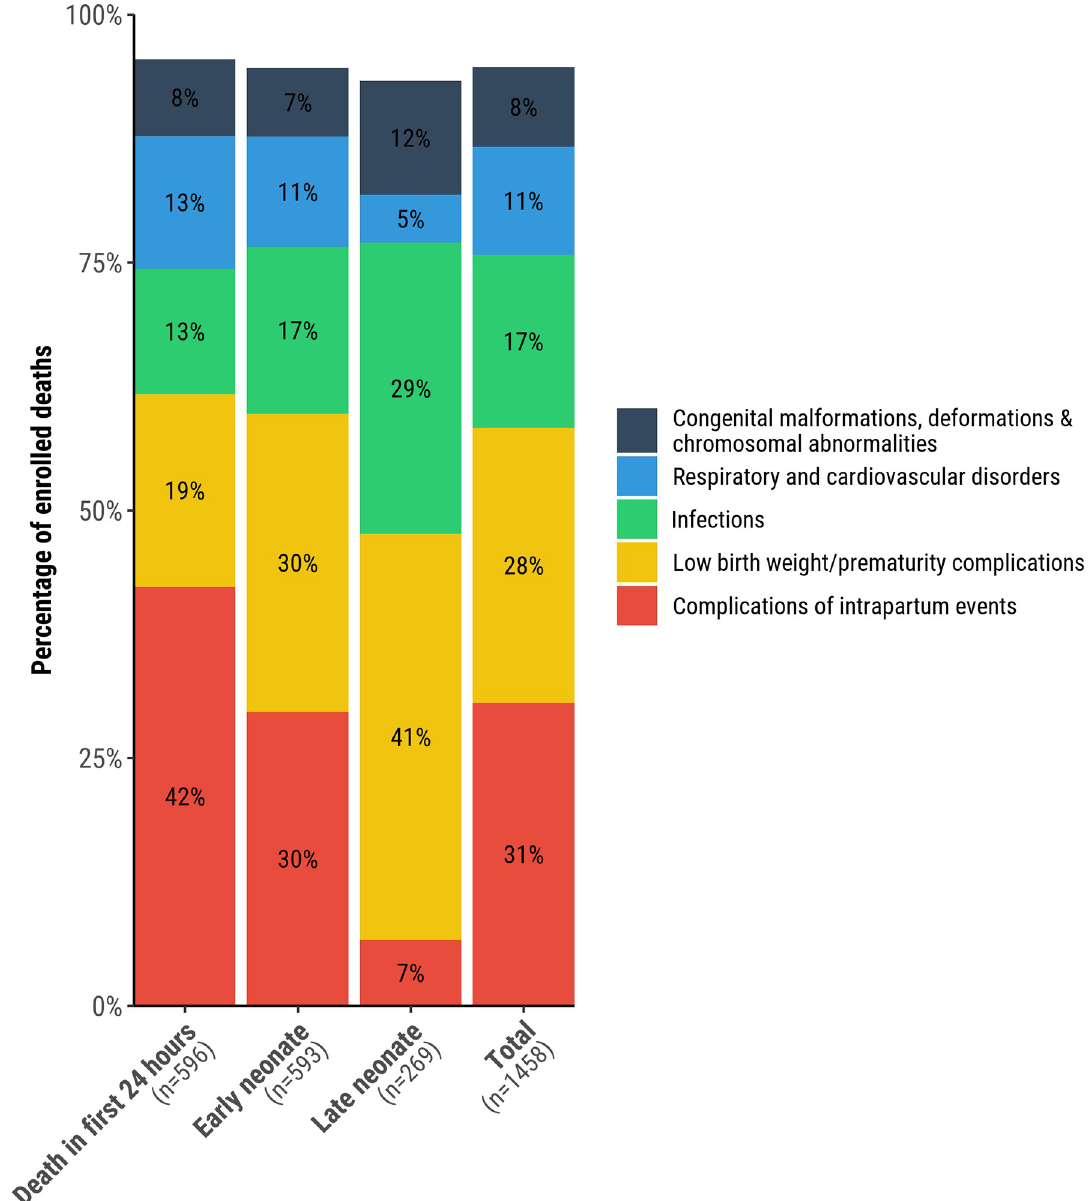
Fig 2. Relative proportion of neonatal deaths enrolled in CHAMPS, 2017–2021, attributed to the 5 most common categories of underlying causes (n = 826), overall and for deaths in the first 24 hours of life, early neonatal period (1–6 days), and late neonatal period (7–27